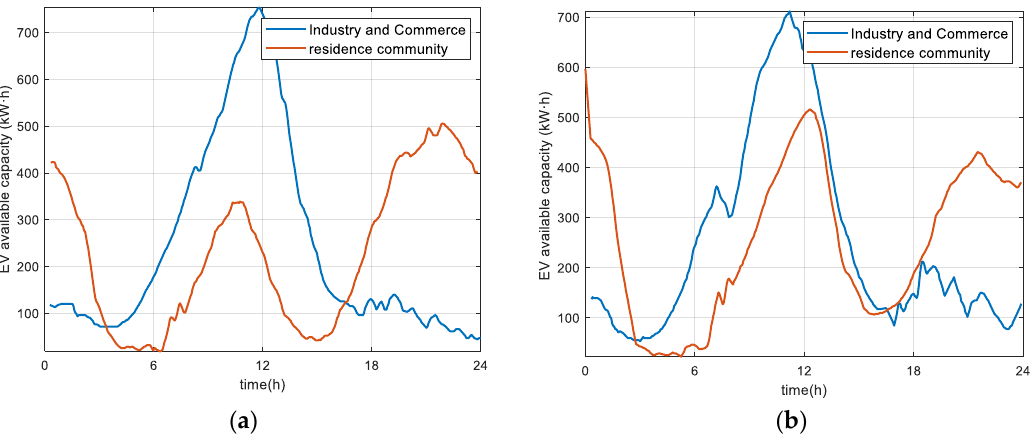
Figure 8. Electric vehicle discharge capacity: ( a ) non-working day EV capacity; ( b ) weekday EV capacity.